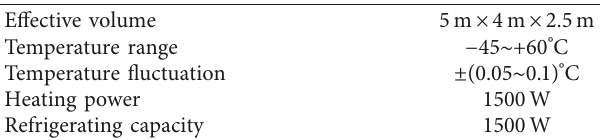
Figure 1: ISOMET 2114 thermal characteristics analyzer. Table 4: Performance parameters of the high-low temperature simulation test